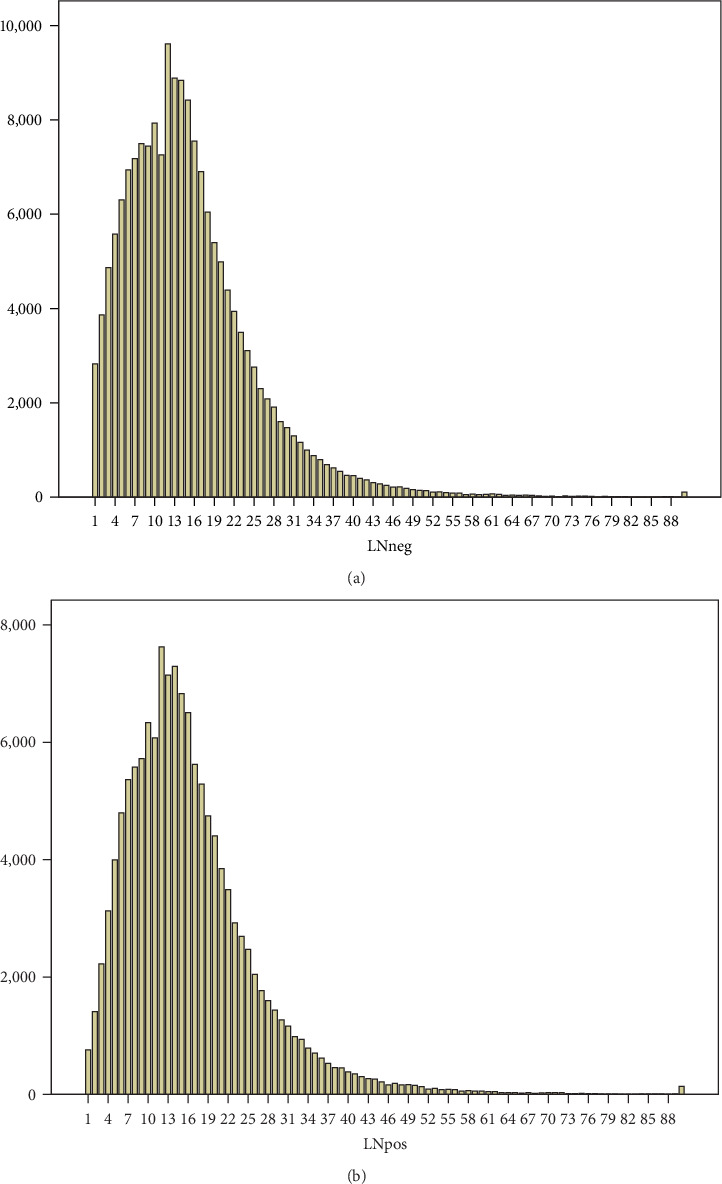
ELN number distribution of stage II (a) and III CRC (b).